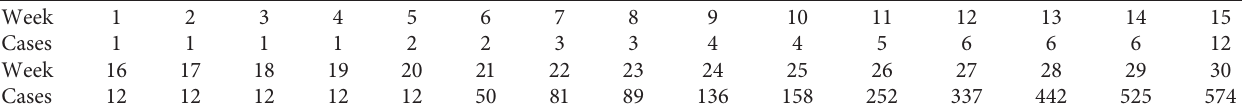
Table 1: Cumulative number of Ebola cases for Sierra Leone for the duration